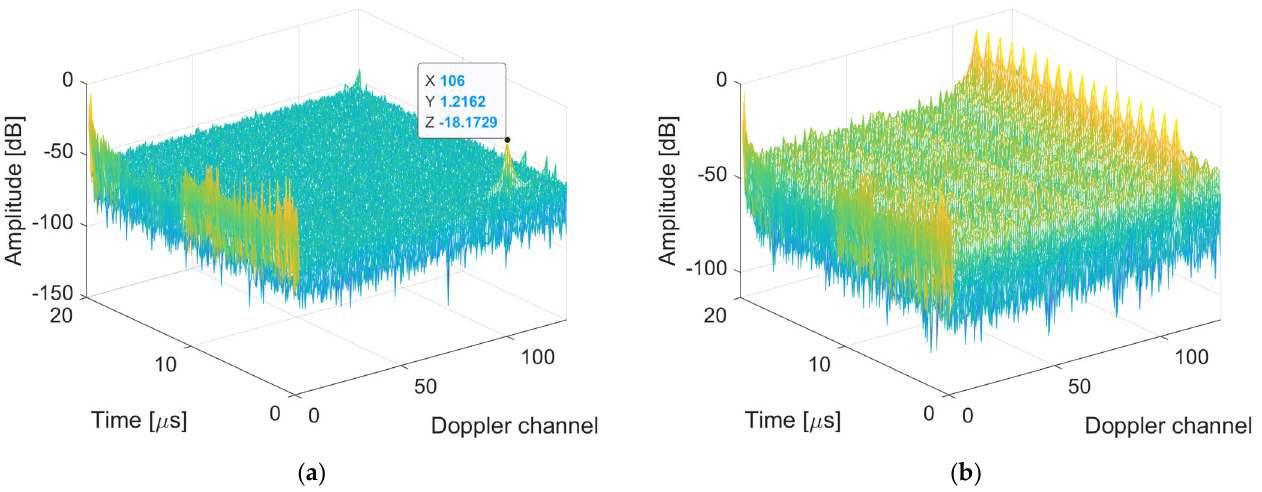
Figure 18. MTD results of target tracking: ( a ) without jamming; ( b ) with jamming. Furthermore, the SAR imaging simulation of the curve trajectory was completed at the personal computer (PC) end. The jamming echo data received by SDR were superimposed on the SAR imaging echo at the PC end, and the results are shown in Figure 19. Under the influence of jamming, the image’s contrast is decreased and the detail information is covered by jamming, leading to multiple false targets in the range